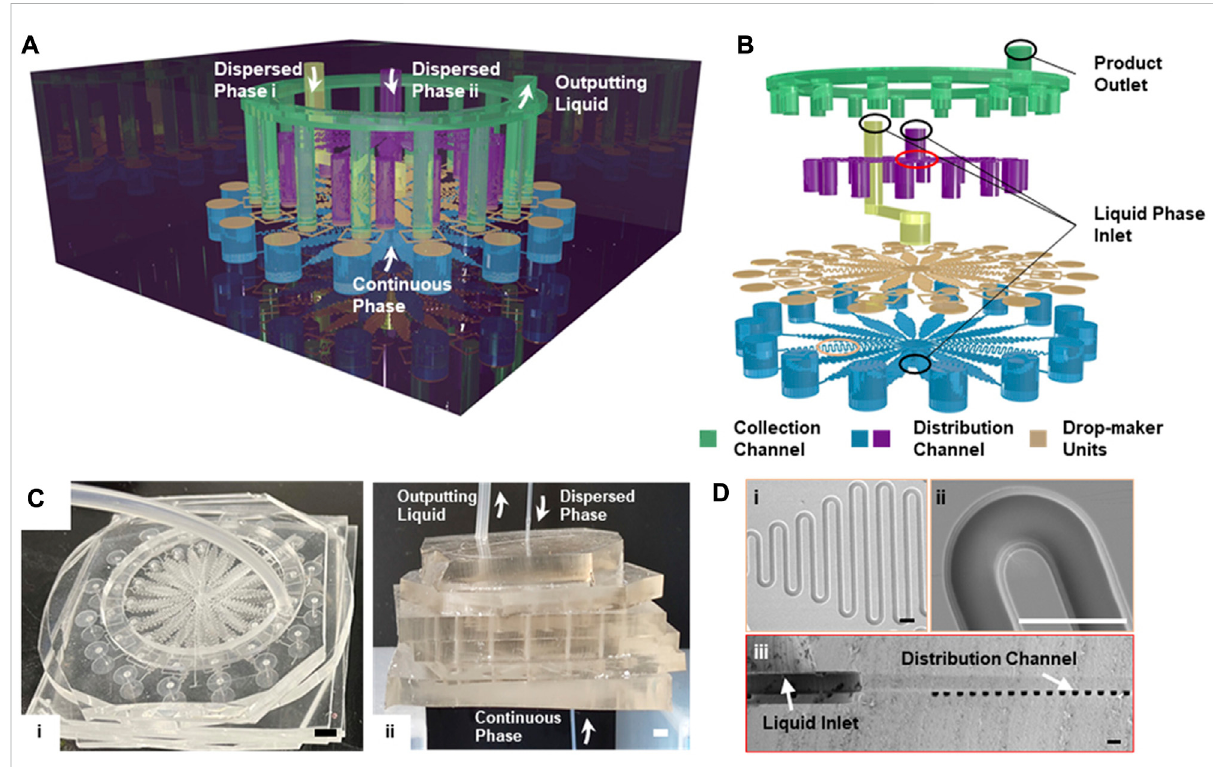
FIGURE 1 Schematic illustration of the integrated micro fl uid chip design (A) The multi-layered structure of the 16× DMUs integrated chip for structured microgels. (B) The stacked con fi guration of the microchannels within the integrated chip (C) Photograph showing the overall (i) and the side view (ii) of the integrated micro fl uidic chip containing DMUs with the channel width of 300 µm. Scale bar is 2 mm (D) The SEM image showing the overall (i) anddetailed(ii)viewsofthedistributionchannel,andthecross-sectionoftheliquidinletandthedistributionchannel(iii).Scalebarsare100 μ